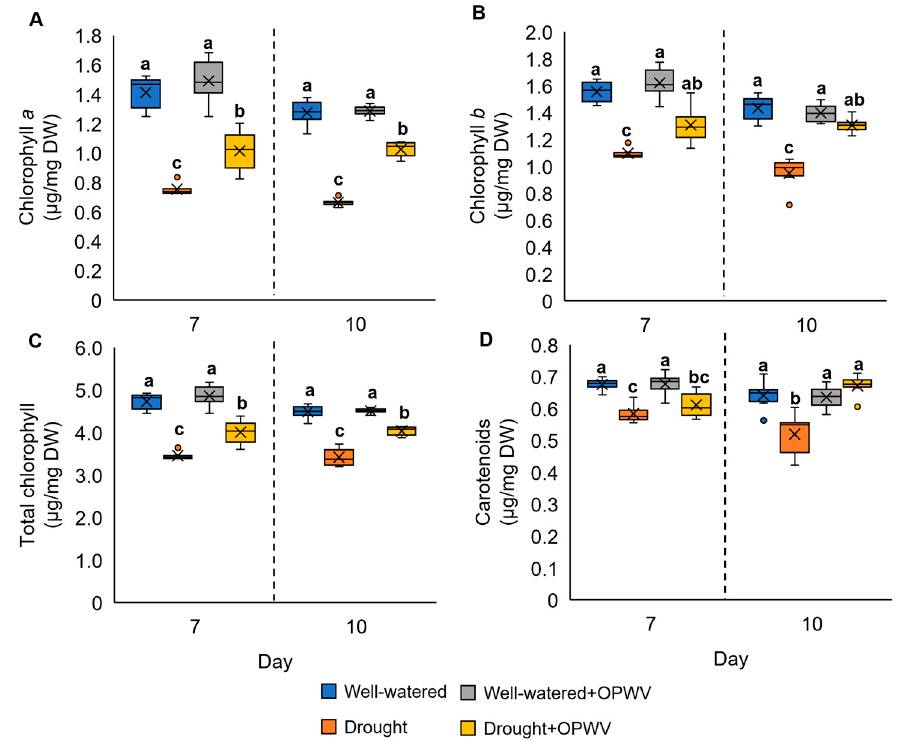
Figure 5. The pigmentation constituents of the well-watered and drought-stressed plants with or without OPWV for 7 and 10 days. ( A ) Chlorophyll a (µg mg − 1 DW). ( B ) Chlorophyll b (µg mg − 1 DW). − 1 DW). ( D ) Carotenoids ( µ g mg − 1 DW). The letter labelled on the ( C ) Total chlorophyll (µg mg − 1 DW). ( D ) Carotenoids (µg mg − 1 DW). The letter labelled on the mean ( C ) Total chlorophyll ( µ g mg